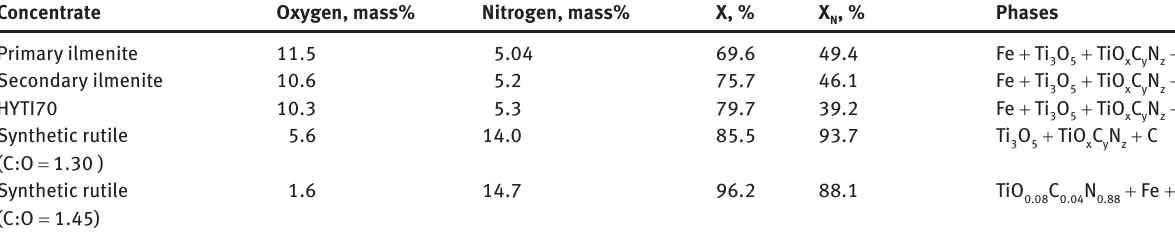
Table 3: LECO analysis and phase composition of ilmenite concentrates and synthetic rutile subjected to temperature programmed reduction in